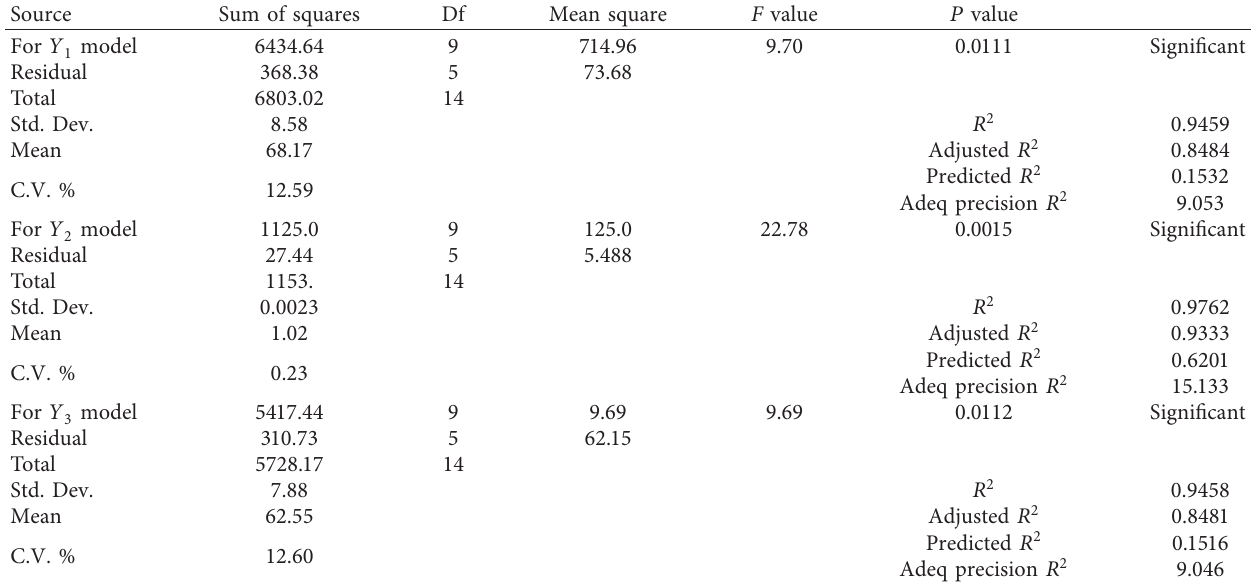
Table 4: ANOVA table for the fitted